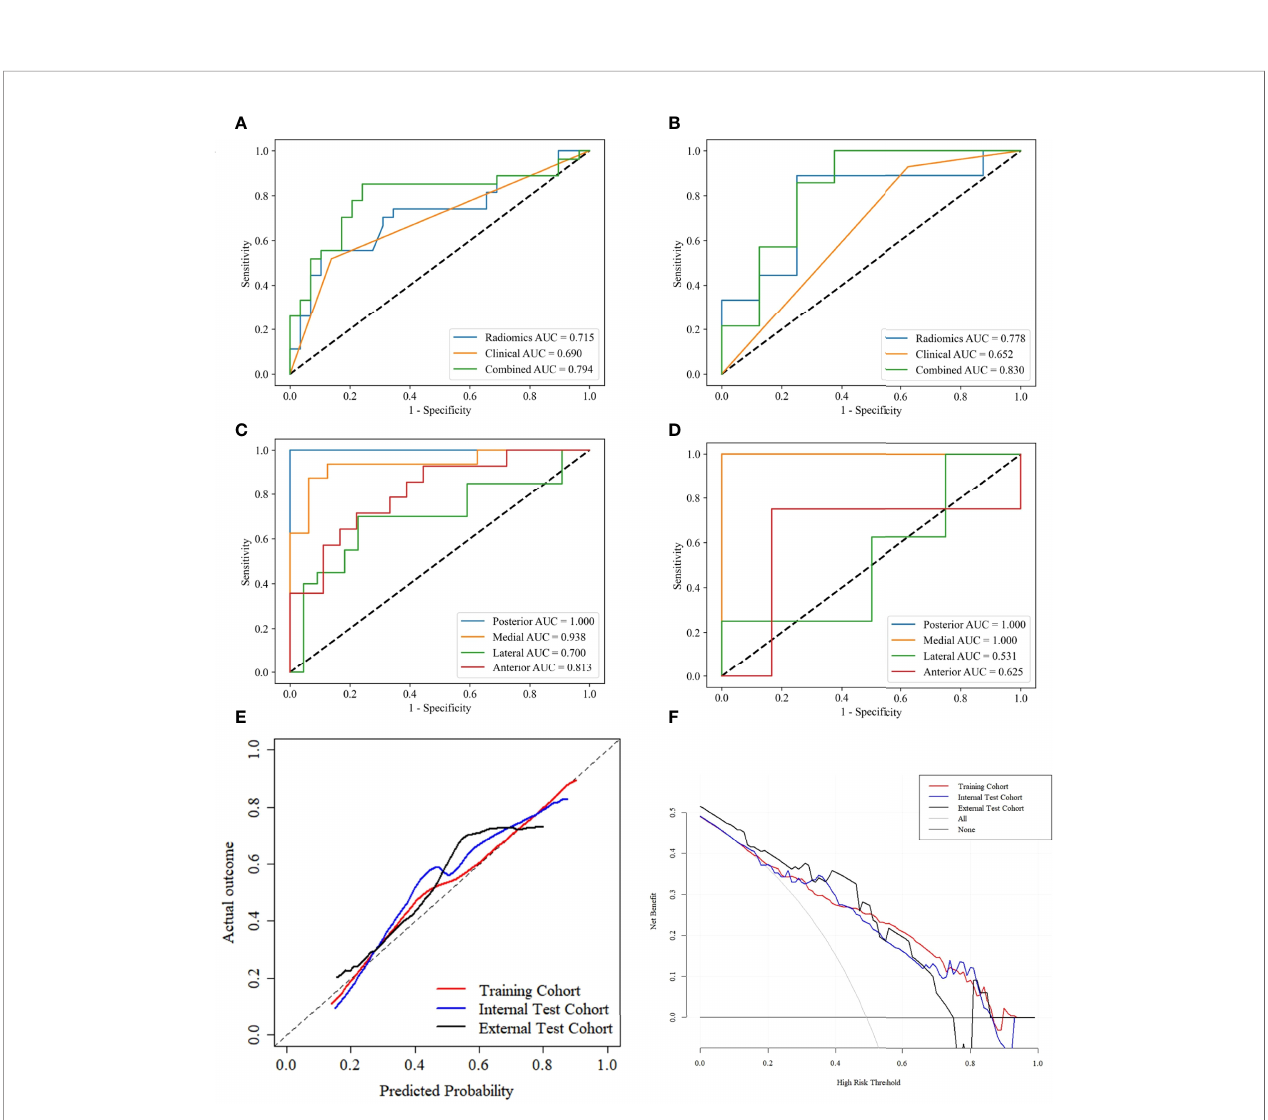
FIGURE 6 | ROC curves of PTCs close to thyroid capsule in the internal test (A) and external test (B) cohorts. ROC curves for predicting lesions close to different adjacent structures using the combined L-SVM model in the internal test (C) and external test (D) cohorts. Calibration curves of the combined-L-SVM models in the training, internal test and external test cohorts (E) . DCA of the combined-L-SVM models in the training, internal test and external test cohorts (F) .